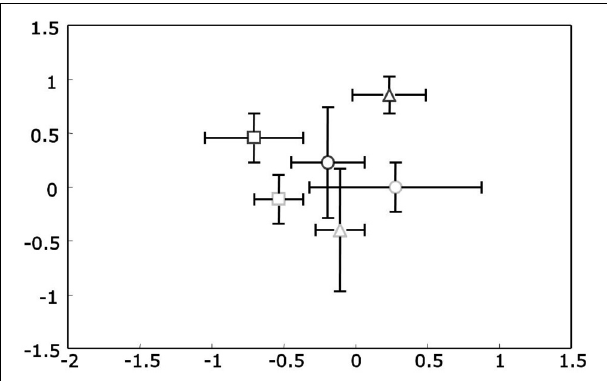
FIGURE 3 | Non-metric Multidimensional Scaling (NMS) plots of PKS Type II t-RFLP profiles for rhizosphere DNA. Upright triangles indicate spring, circles summer and squares autumn samples. Ozone treated samples are shown in gray, while controls are black. Stress value was 4.96 given according to Kruskal’s stress formula 1 multiplied by